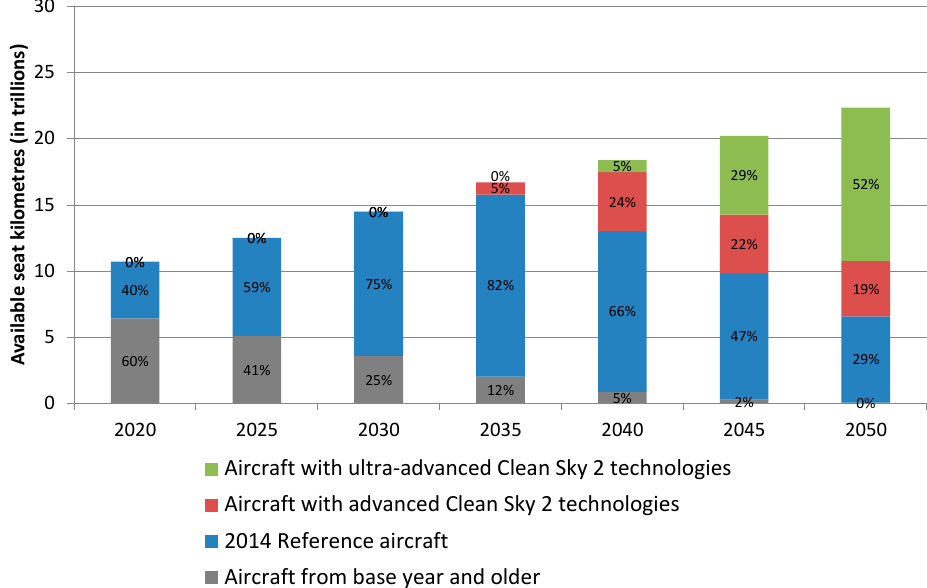
Figure 17. Available seat kilometres (ASK) by technology level in the Low Scenario. The grey, blue, red and green bars add up to the total ASK volume for the respective year.